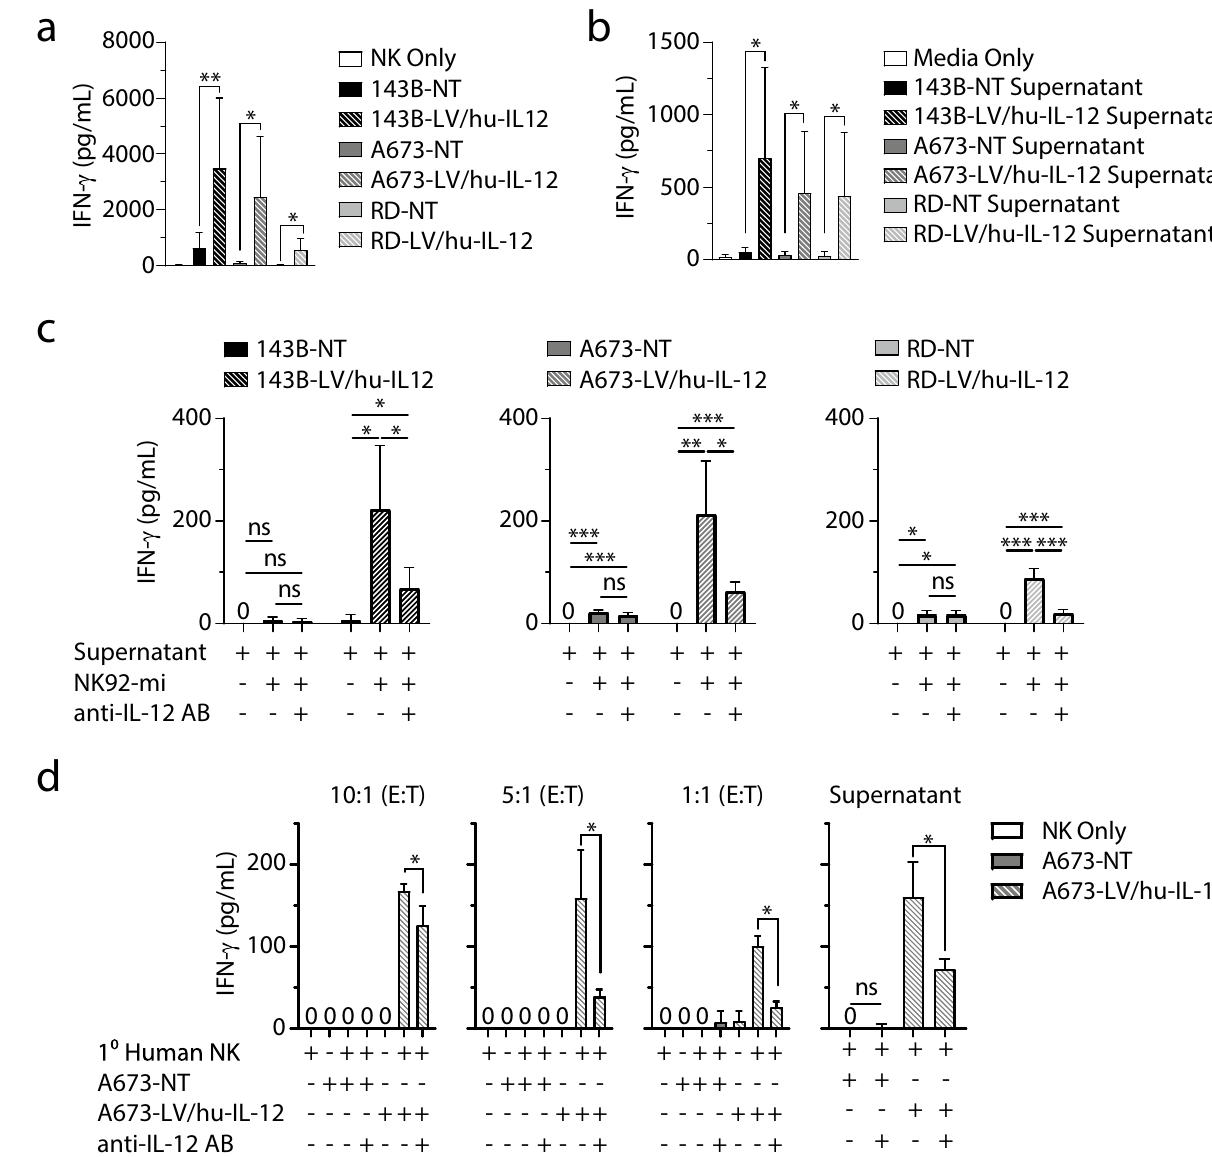
Figure 2. ( a ) Non-transduced (NT) and LV/hu-IL-12 transduced human sarcoma lines for osteosarcoma (143B), Ewing sarcoma (A673), and rhabdomyosarcoma (RD) were plated in ultralow adherent 96-well plates. After 48 h of growth, media or NK-92mi at a 10:1 ratio were added. Supernatants were assessed by ELISA for IFN-γ. N = 12; 3 independent experiments, displayed mean ± standard deviation. ( b ) Non-transduced and LV/ hu-IL-12 transduced human sarcoma lines were plated. 4 h later conditioned supernatant was collected and 100 µL applied to NK-92mi cells. After an additional 4 h supernatant was collected, and IFN-γ was measured by ELISA. N = 6; 2 independent experiments, displayed mean ± standard deviation. ( c ) NK-92mi cells were incubated in the presence or absence of anti-IL-12 antibody and 100 µL of conditioned supernatant. After 4 h supernatant was collected, and IFN-γ was measured by ELISA. N = 6; 2 independent experiments, displayed mean ± standard deviation. ( d ) Primary human NK cells were plated with non-transduced (NT) and LV/hu-IL- 12 transduced human Ewing sarcoma (A673) at the noted E:T ratios or conditioned supernatant (100 µL) in the presence or absence of anti-IL-12 antibody. After 6 h supernatant was collected, and IFN-γ was measured by ELISA. N = 3; displayed mean ± standard deviation. * = p < 0.05, ** = p < 0.001, *** = p <